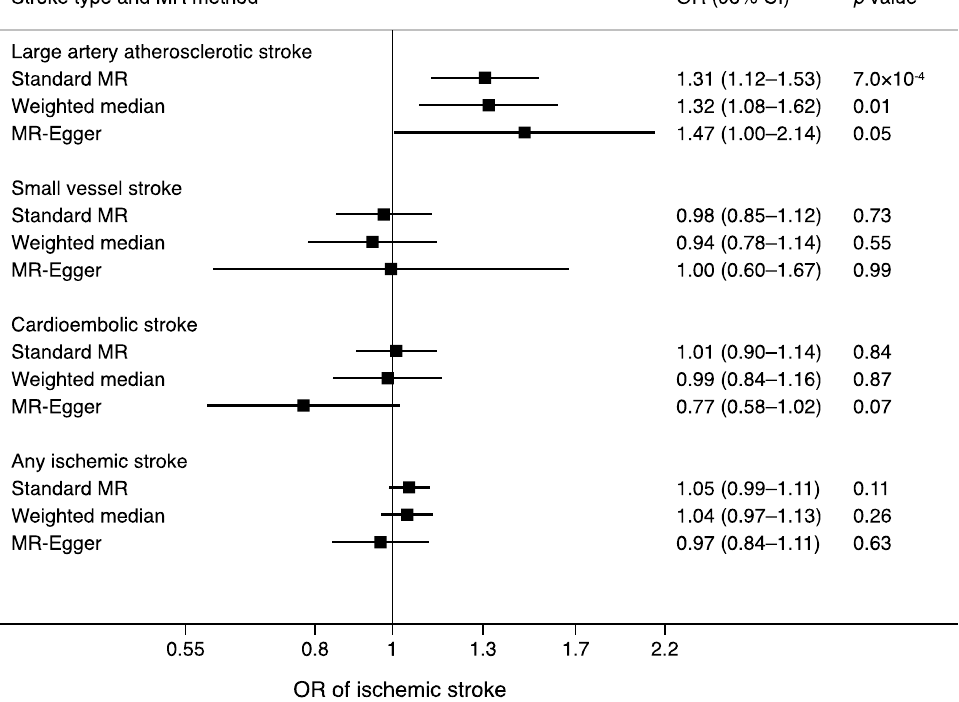
Figure 2. Associations of genetically predicted 1 nmol/L increase in natural log-transformed vitamin K 1 levels with ischemic stroke subtypes and any ischemic stroke in different MR analyses. CI, confidence interval; MR, Mendelian randomization; OR, odds ratio.